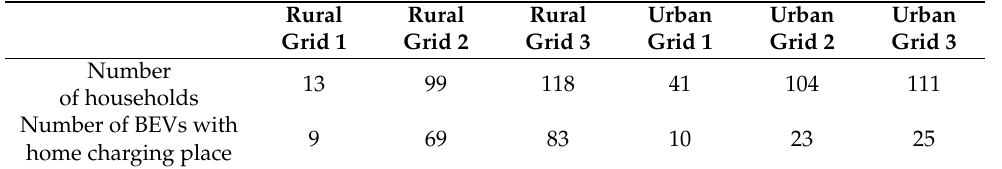
Table 3. Number of households and BEVs within the examined grids [14].